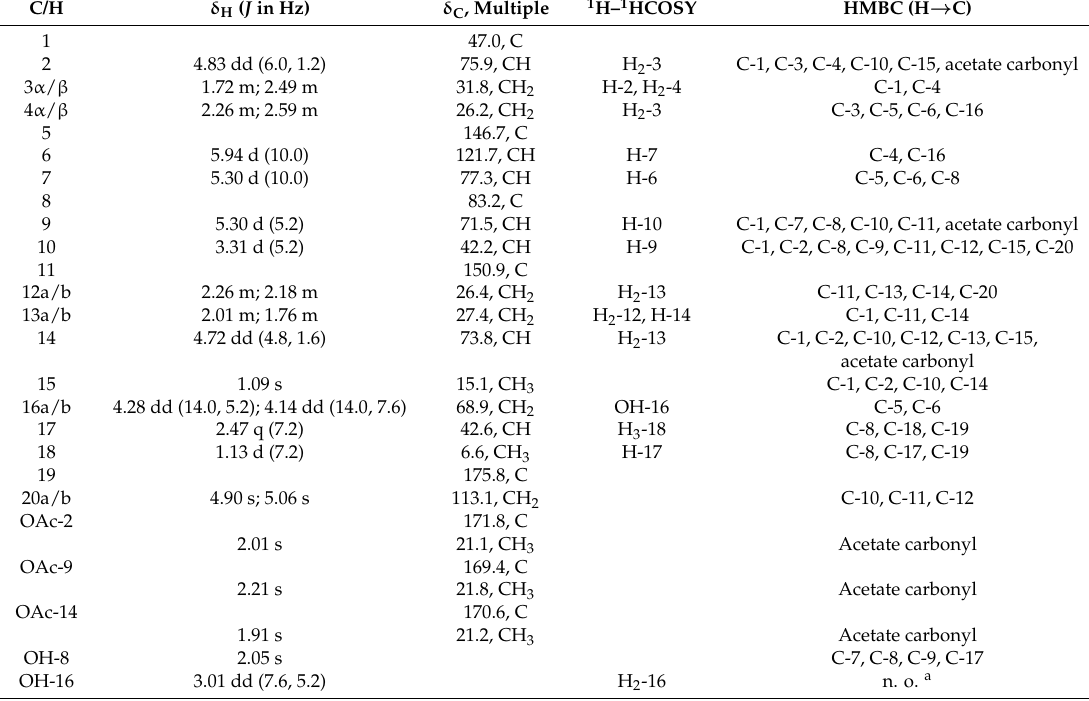
Table 2. 1 H (400 MHz, CDCl 3 ) and 13 C (100 MHz, CDCl 3 ) NMR data, 1 H– 1 H COSY and HMBC correlations for briarane